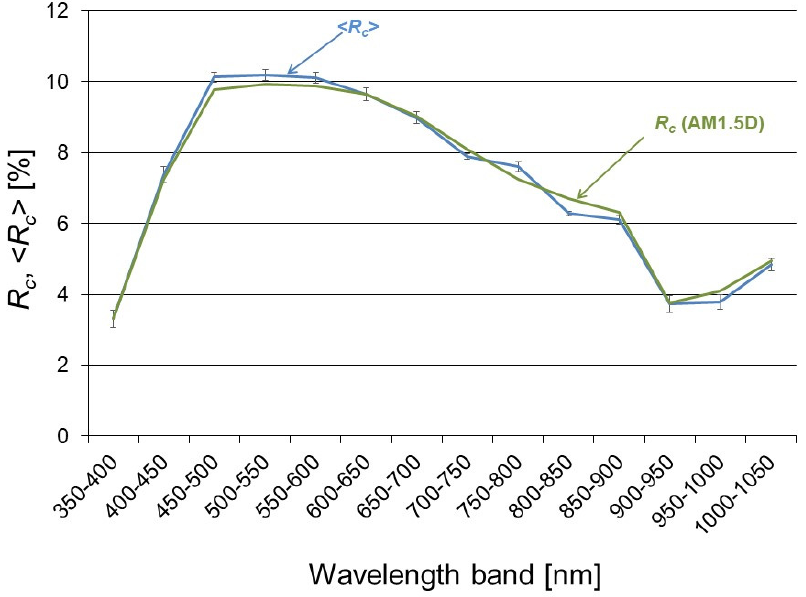
Figure 2. Mean percentage contributions to direct normal irradiance (DNI)—integrated from 350 to 1050 nm—across all 50-nm bands for spectral measurements with Average Photon Energy (APE) and air mass (AM) values of 1.85 ± 0.01 eV and 1.5 ± 0.05, respectively, recorded at Jaén (blue line): error bars indicate the standard deviation (SD) values related to each of these bands. The “reference” Rc values calculated for each of these bands from the standard AM1.5D spectrum are also shown (green line).